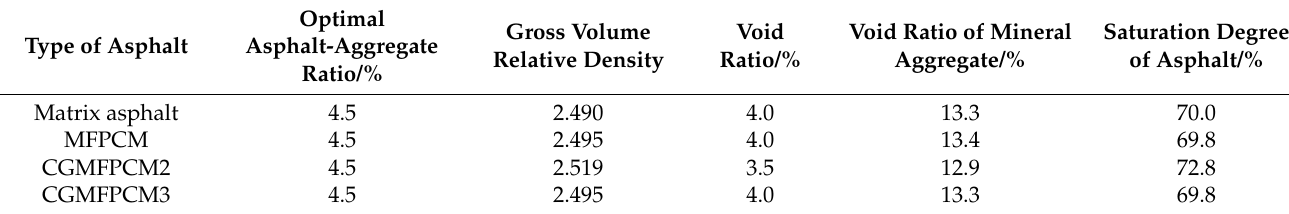
Table 4. Optimal asphalt-aggregate of the AC-16 bitumen.